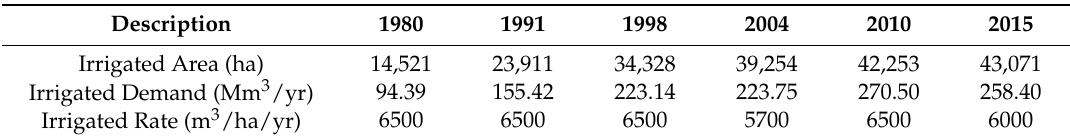
Table 1. Temporal evolution of the irrigated area in Campo de Cartagena in terms of average irrigation endowments